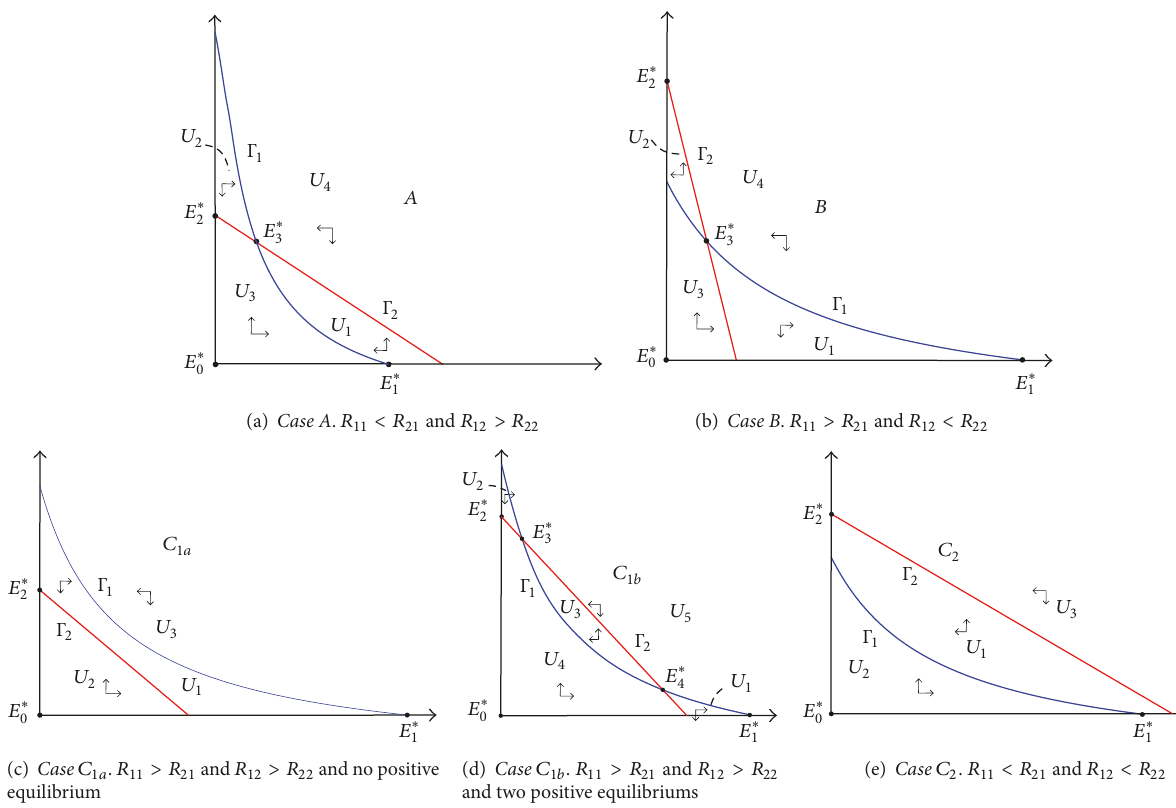
Figure 1: Different configurations of isoclines and equilibrium points of system (20) when 𝜙 𝑖 (0,0) > 1 for 𝑖 = 1, 2 , in terms of the relative position of the intercepts of isoclines, 𝑅 𝑖𝑗